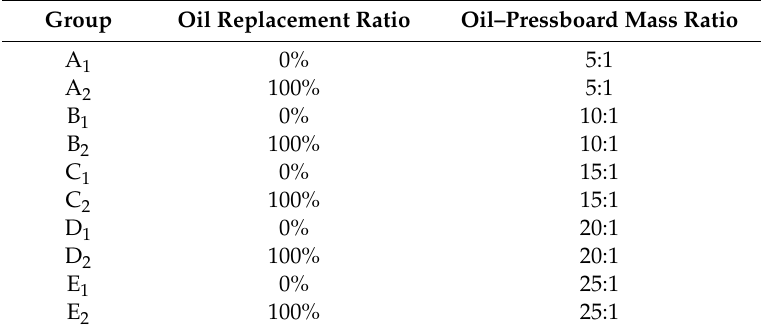
Table 2. Experimental scheme.